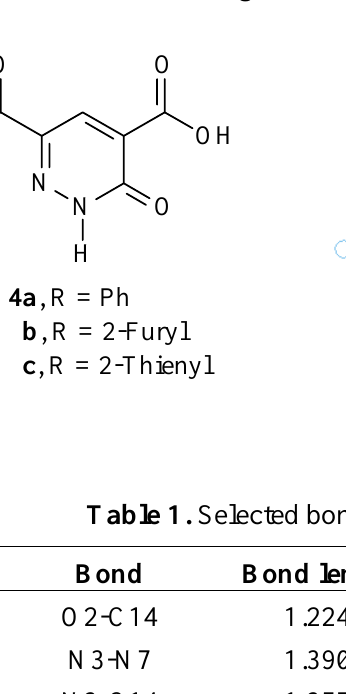
Figure 1 . X-Ray crystal structure of 4b .